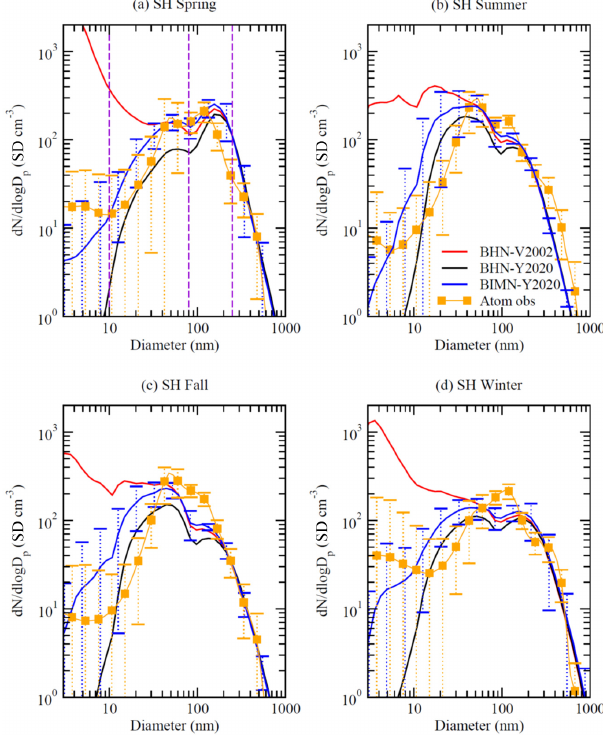
Figure 6. Model-simulated seasonal mean PNSDs at a site in the SH (70 ◦ S, 60 ◦ W) at an altitude of 12km based on three nucle- ation schemes and comparisons with the corresponding ATom mea- surements ( a : SH spring in September–October 2017, b : SH sum- mer in January–February 2017, c : SH fall in April–May 2018, and d : SH winter in June–July 2016). To take into account the varia- tions in both model and observed PNSDs, standard deviations are shown as error bars in the measured and modeled curves based on BIMN_Y2020. Three vertical dashed lines at 10, 80, and 250nm are drawn in (a) to guide the eye to the four modes discussed in the